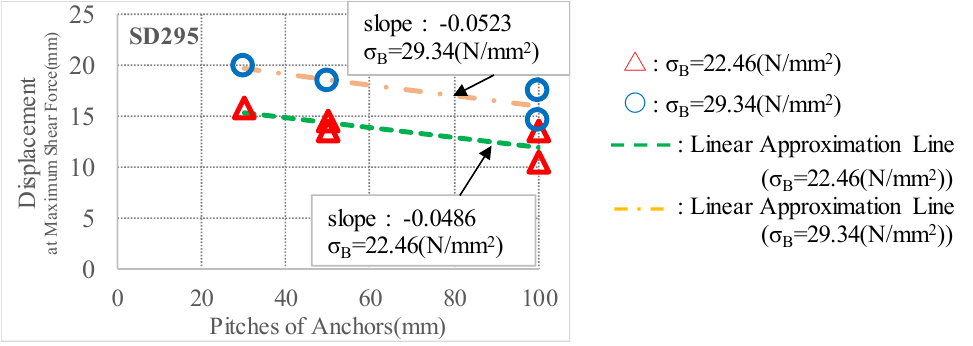
Figure 7. Displacement at maximum shear force - pitches of anchors relations. (SD295)